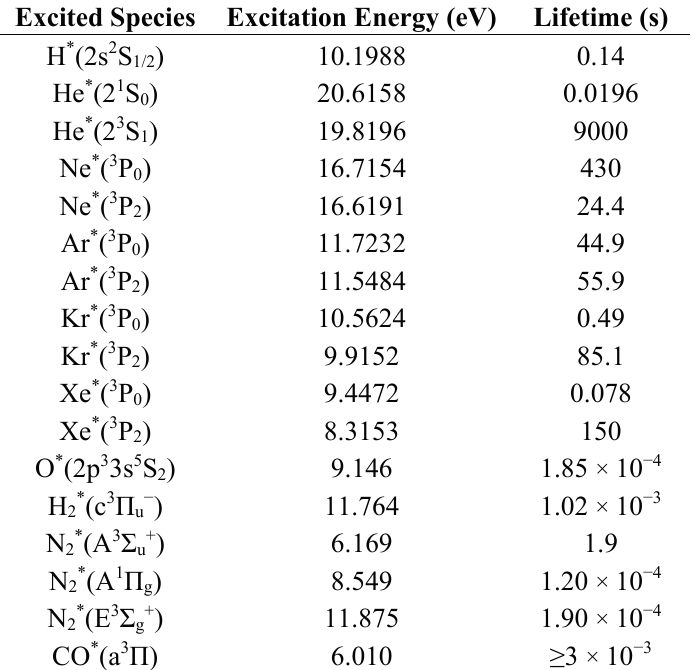
Table 1. Some characteristics of metastable atomic and molecular species